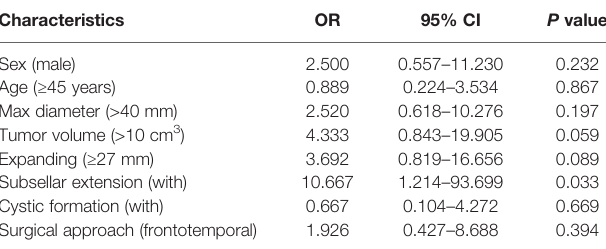
TABLE 7 | Univariable logistic regression analyses of predictors for gross total resection. Characteristics